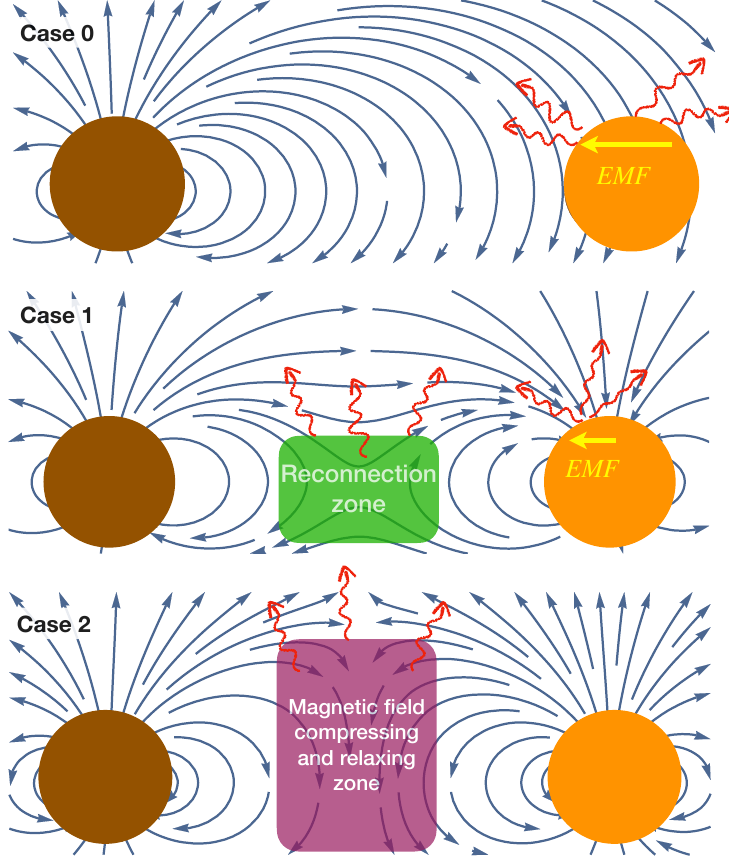
Figure 1. We show the schematics of three typical magnetic field configurations in inspiraling NS binaries: case 0 with B c < µ ∗ a − 3 , case 1 with µ ∗ ∼ − µ c , and case 2 with µ ∗ ∼ µ c . The red winding arrows represent the emitted